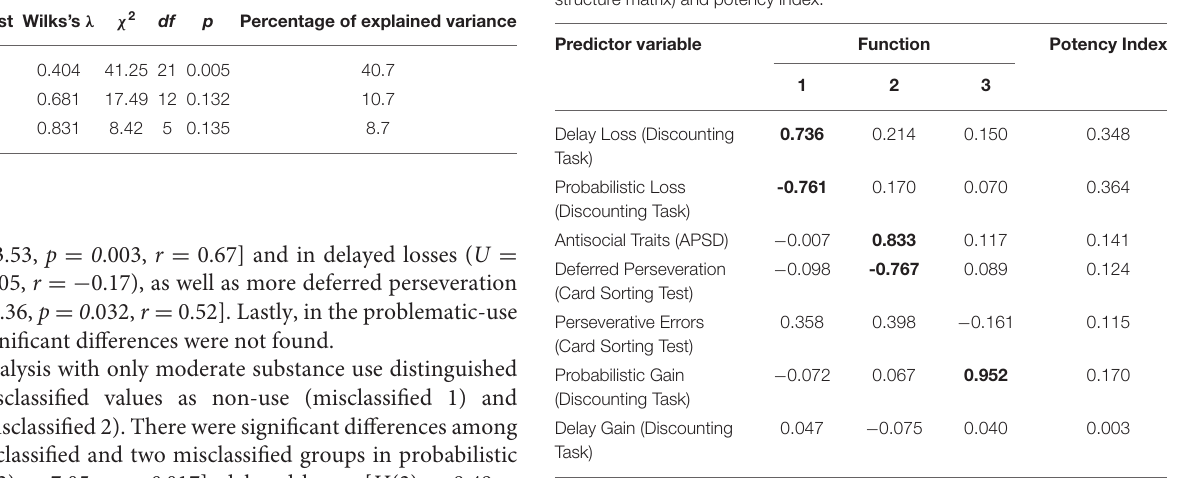
TABLE 2 | Functions in simultaneous discriminant function analysis. TABLE 3 | Standardized discriminant functions coefficients (rotated function structure matrix) and potency